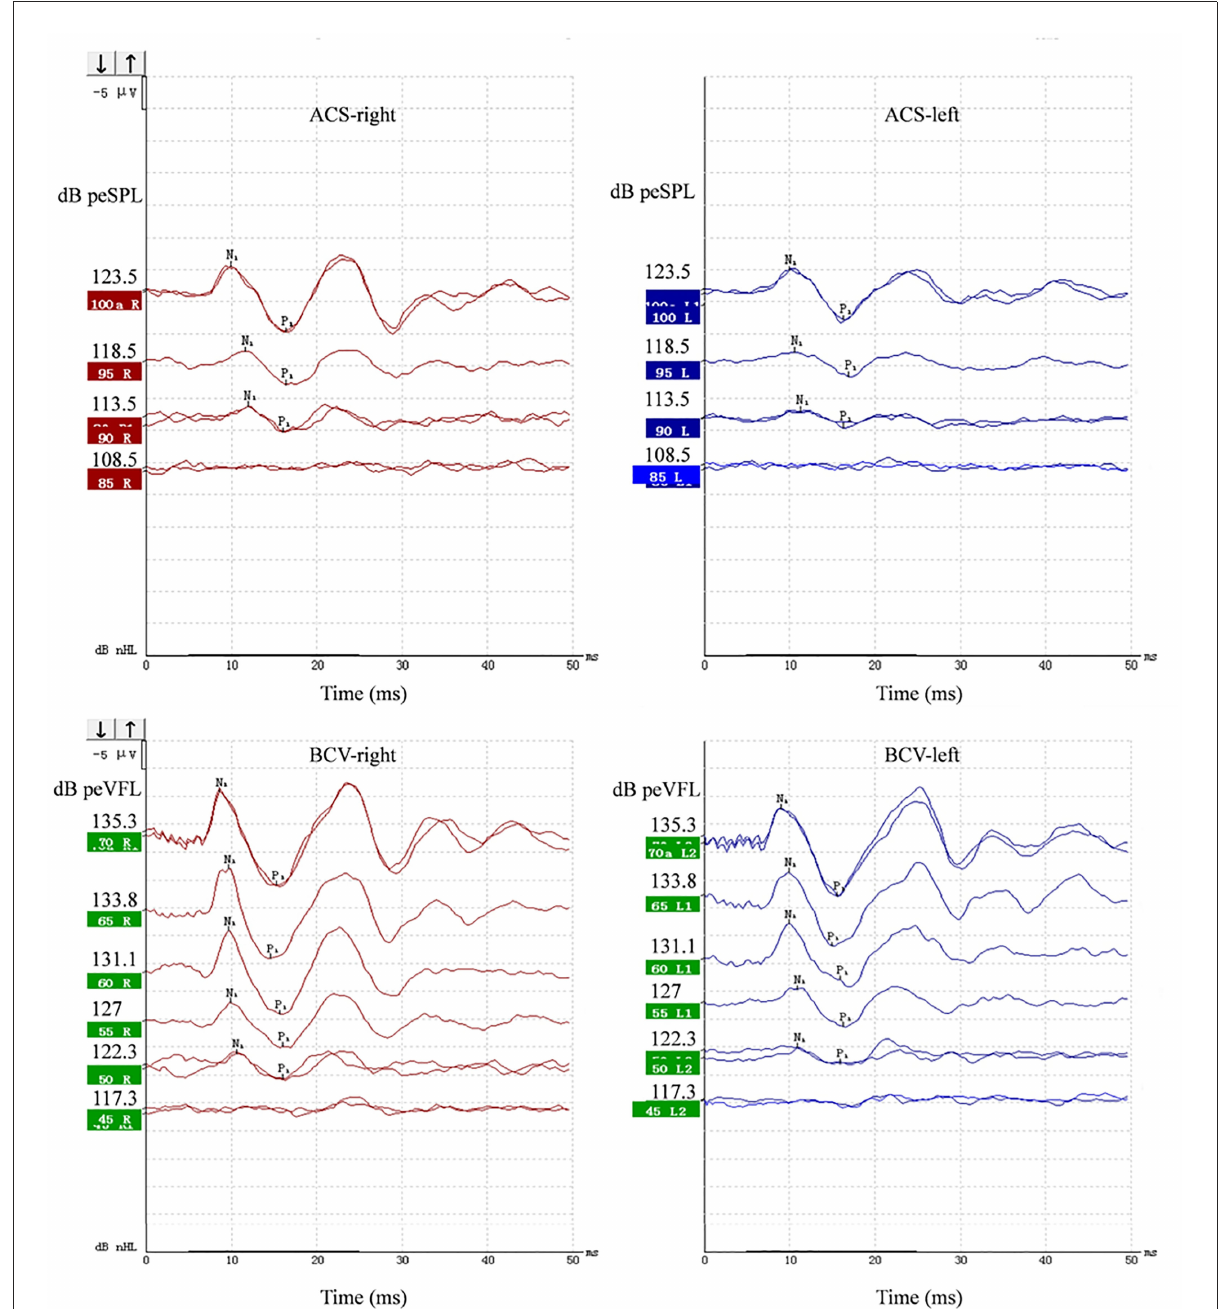
FIGURE1 Representative ACS and BCV oVEMPs from a 19-year-old female. Primitive test value of tone burst parameter and corresponding sound pressure level or force level value were all marked on the Y -axis of each wave. The unit was peak-to-peak equivalent sound pressure level (peSPL) when using ACS and peak-to-peak force equivalent vibratory force level (peVFL) when using BCV.